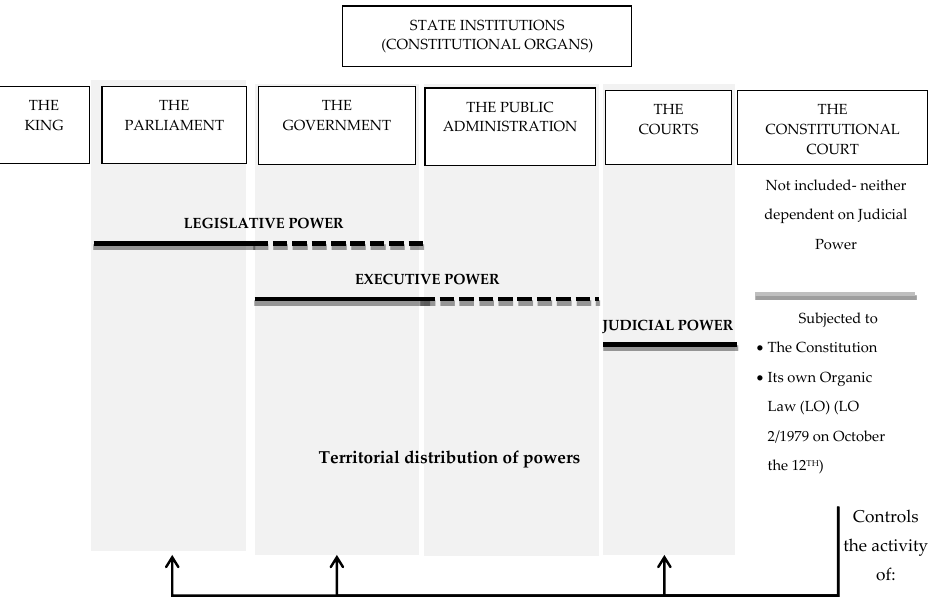
Figure 2. Territorial distribution of powers